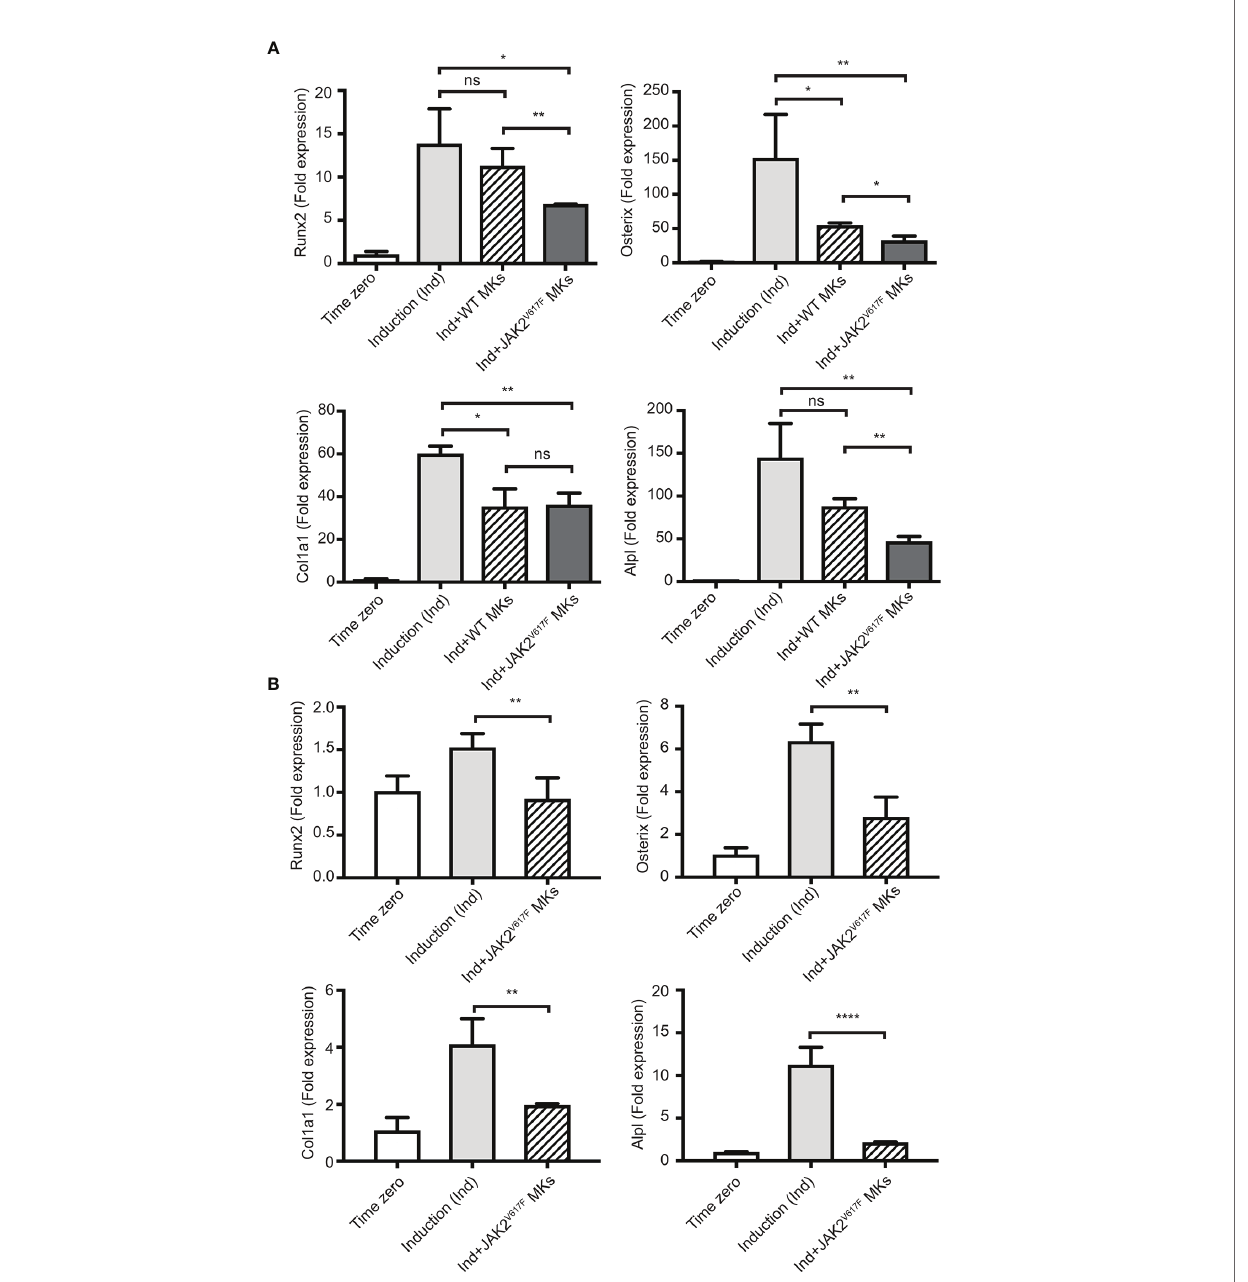
FIGURE 3 | Inhibition of the OB differentiation program by JAK2 V617F MKs. Bone marrow cells were cultured and differentiated towards OBs with an induction mix in presence or absence of JAK2 V617F mutated or control WT MKs for three days, as described under methods. RNA was isolated from differentiating OBs and quantitative RT-PCR was carried out to detect the expression of early differentiation markers of OBs, including Runx2, Osterix, Col1a1 and Alpl. Data were normalized to 18S rRNA and values were compared to time zero, where this point refers to samples that were isolated right before the beginning of induction of OB differentiation. P-values were acquired with an unpaired two-tailed t-test. (A) JAK2 V617F MKs (derived from ten 18 weeks old male mice per experiment) inhibit OB differentiation of mesenchymal progenitors (derived from ten 13 weeks old WT mice). Shown is an experiment performed in triplicates, representative of three biological repeats. (B) JAK2 V617F MKs (derived from four 13 weeks old male mice) inhibit OB differentiation of mesenchymal progenitors derived from JAK2 V617F mice (four 14 weeks old male mice per experiment). *Denotes p<0.05; **Denotes p<0.01; ****Denotes